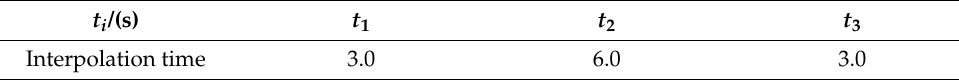
Table 3. Interpolation times of the joints.